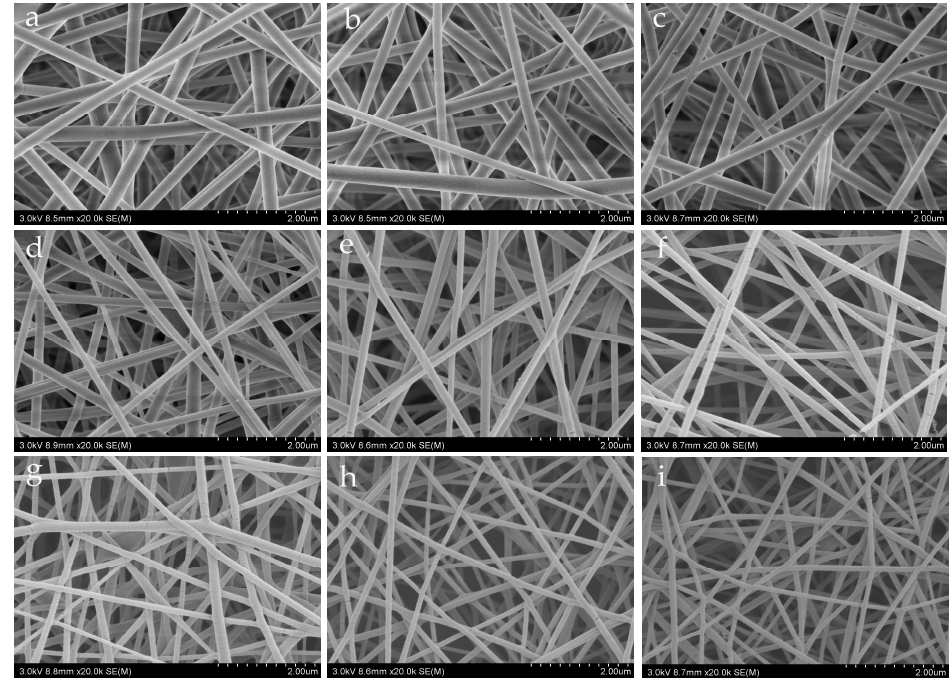
Figure 6. SEM images of PVA membranes obtained by different needles, ( a ) 6 mm, ( b ) 11 mm ( c ) 16